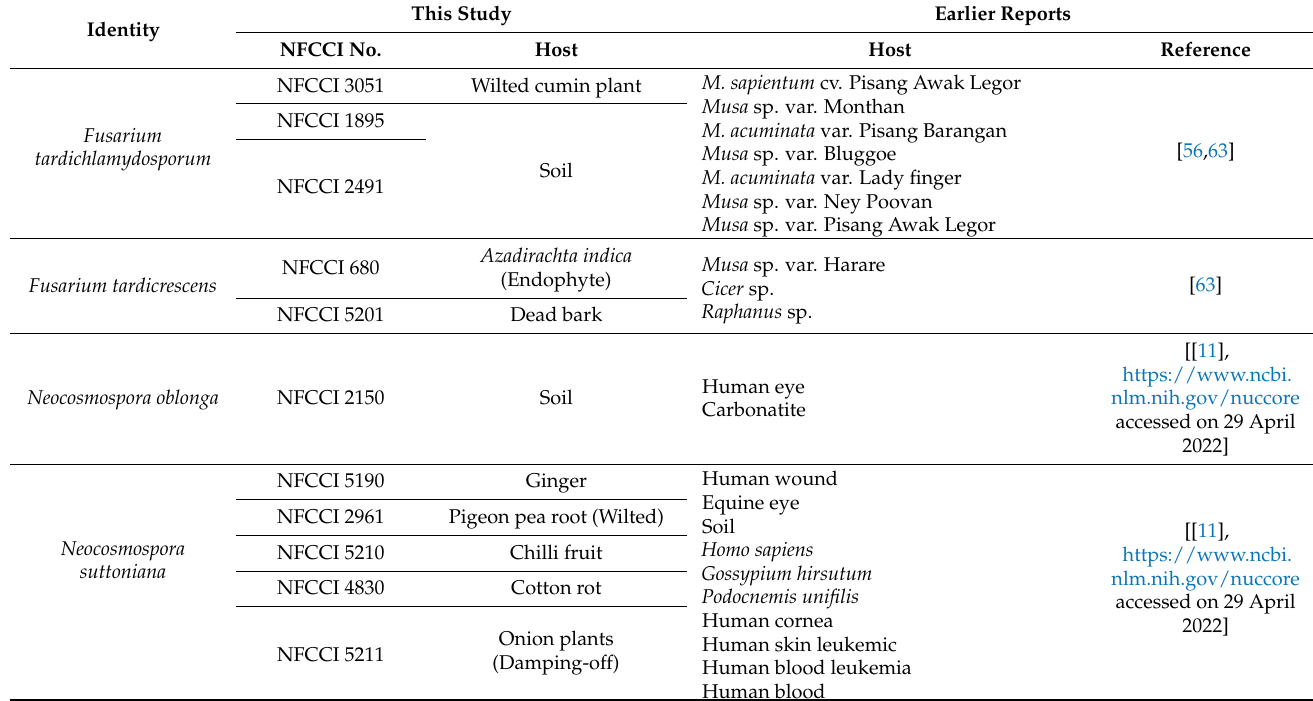
Figure 3. Maximum-likelihood (IQ-TREE-ML) consensus tree inferred from the combined ITS, LSU, Rpb2, β -tub, CaM and Tef1 multiple sequence alignment of genus Fusarium and releted genera. Num- bers at the branches indicate statistical support values (UFBS and SH-aLRT). The scale bar indicates expected changes per site. The tree is rooted to Atractium stilbaster (CBS 410.67). Isolates used in this study are shown in blue bold.